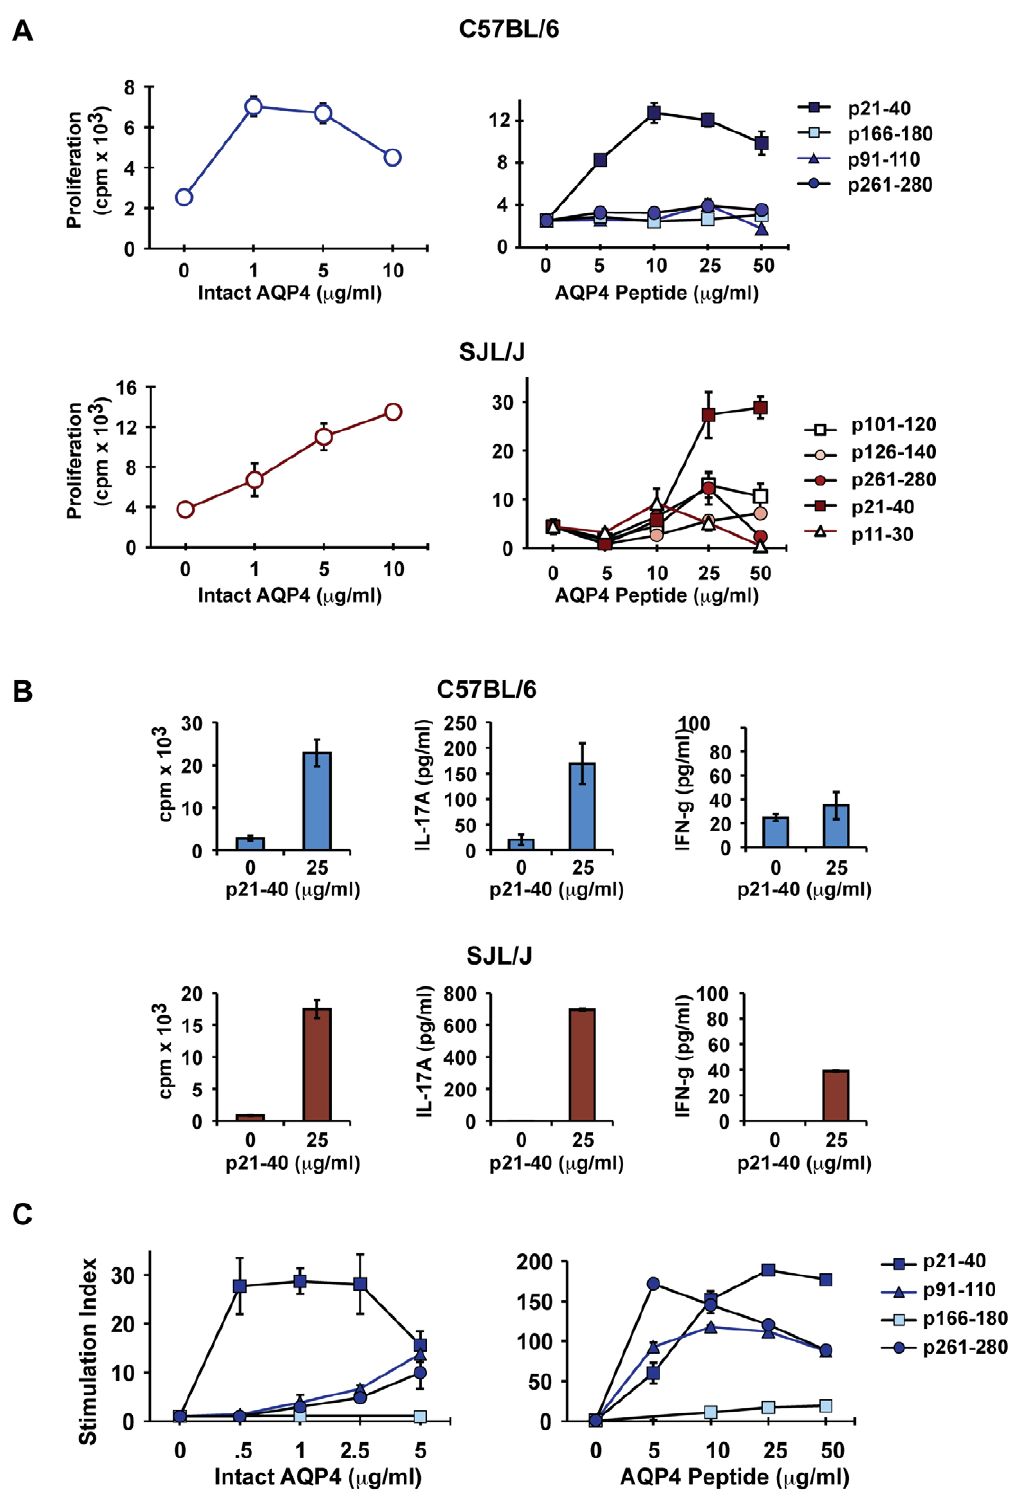
Figure 4. AQP4 p21-40 is a naturally processed immunodominant determinant of intact AQP4. (A) C57BL/6 (above) and SJL/J (below) mice were immunized subcutaneously with 100 m g recombinant intact hAQP4 in CFA. Lymph nodes were harvested at day 10–12 and cultured in the presence of various concentrations of either intact hAQP4 (left), or individual murine AQP4 peptides (right) for 4 days. Proliferation was measured by 3 H-thymidine incorporation, and are presented as mean cpm + / 2 SEM for triplicates. (B) C57BL/6 (above) and SJL/J (below) m21-40 primed lymph node cells were assayed for cytokine production and proliferation in response to m21-40 peptide. Supernatants were collected after 72 hr for IFN- c and IL-17A for ELISA. Data are presented as mean + / 2 SEM for triplicates. (C) Proliferation of C57BL/6 T cell lines specific to p21-40, p91-110, p166- 180, and p261-280 were assayed following re-stimulation with various concentrations of intact hAQP4 (left) and self-peptides (right). Data are shown as stimulation indices (SI’s) of triplicates of antigen proliferation over no antigen conditions (background). doi:10.1371/journal.pone.0015050.g004 PLoS ONE |